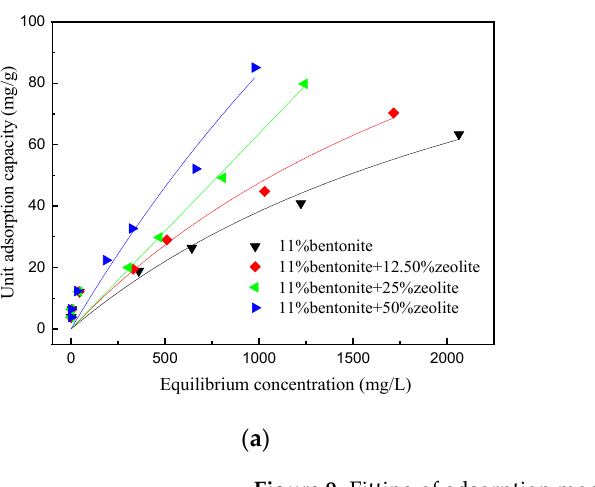
Figure 9. Fitting of adsorption models for mixed soils with simultaneous variations of ZnCl 2 concentration and zeolite dopants. ( a ) Langmuir model; ( b ) Freundlich model. Table 1. Parameters of adsorption model for mixed soils with a simultaneous variation of ZnCl 2 concentration and zeolite dopants.